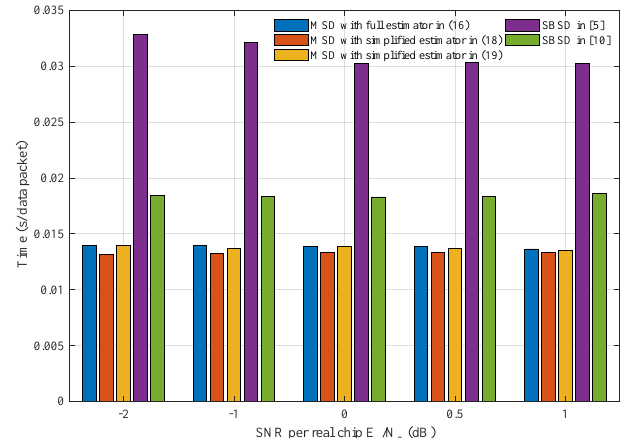
Figure 11. Comparisons of average running time per data packet under various detection schemes over a pure AWGN